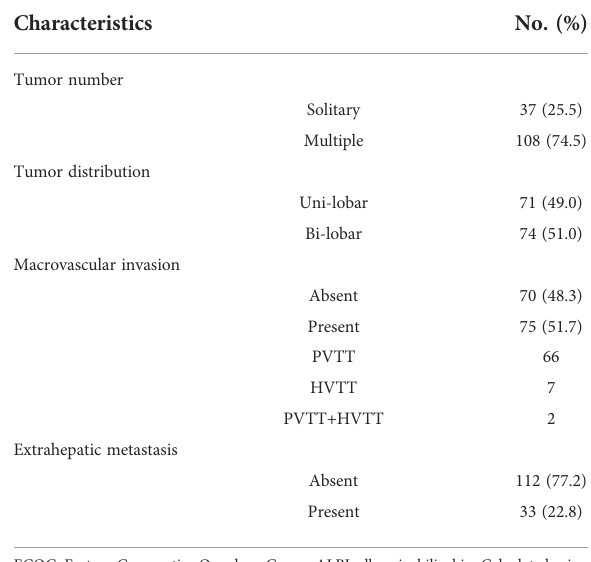
TABLE 1 Baseline clinical